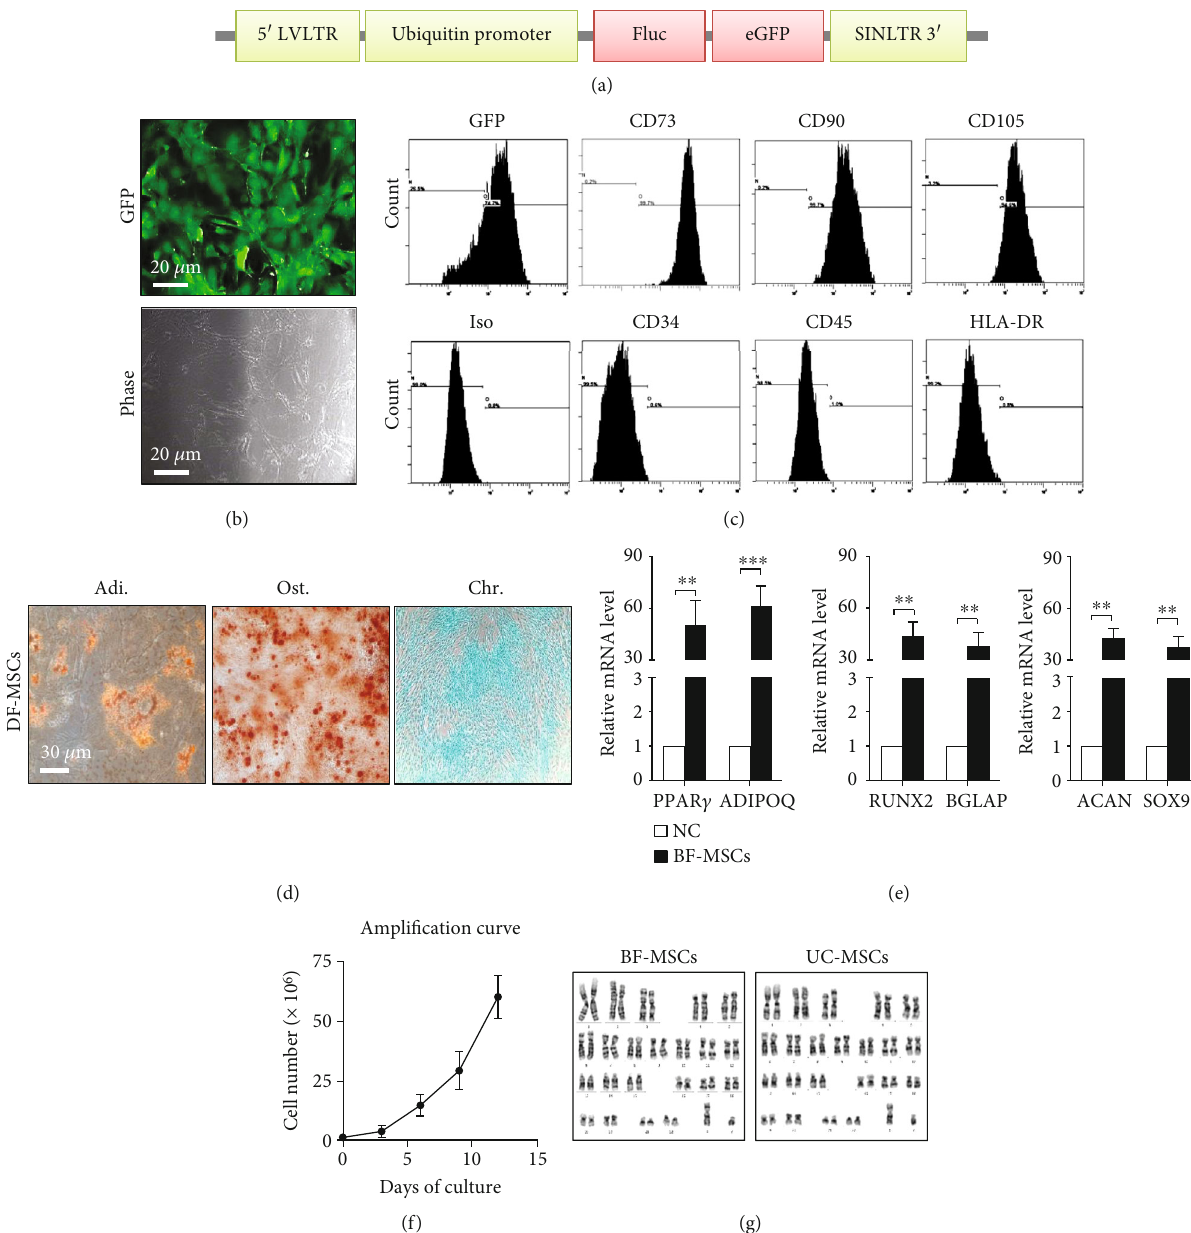
Figure 5: The multifaceted characterizations of the dual- fl uorescence expressing BF-MSCs. (a) Illustration of the lentivirus-mediated dual- fl uorescence reporter construct (pLV-Fluc-eGFP). Fluc and GFP were for BLI and green fl uorescent protein imaging, respectively. (b) The phase contrast and GFP fl uorescence of dual- fl uorescence expressing UC-MSCs (denoted as BF-MSCs). (c) FCM analysis of GFP and MSC-associated biomarker in BF-MSCs. (d) Multilineage di ff erentiation potential (adipogenic, osteogenic, and chondrogenic di ff erentiation) of BF-MSC-derived cells (upper panel) and untreated DF-MSCs (bottom panel) identi fi ed by Oil Red O (left panel), Alizarin red (middle panel), and Alcian blue (right panel) staining, respectively. Scale bar = 30 μ m. (e) qRT-PCR analysis of the adipogenic- (ADIPOQ and PPAR γ ), osteogenic- (RUNX2 and BGLAP), and chondrogenic- (ACAN and SOX9) associated genes in the indicated BF-MSCs ( mean ± SD , n = 3 ). ∗∗ P < 0 : 01 ; ∗∗∗ P < 0 : 001 . (f) Ampli fi cation curve of BF-MSCs based on the cumulative cell numbers and days of cultivation ( mean ± SD , n = 3 ). (g) Karyotypic analysis of UC-MSCs and BF-MSCs cultured in 10%FBS/DF12 medium with G-banded chromosome